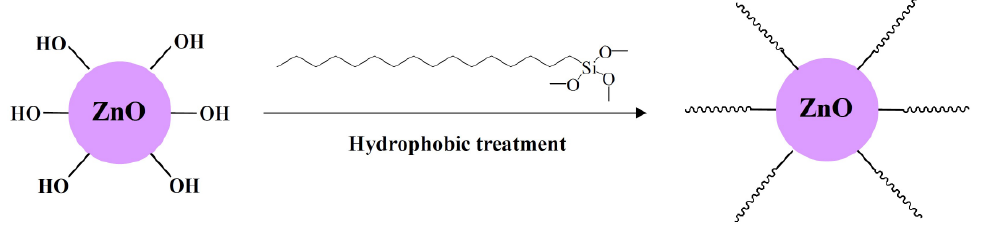
Figure 2. Surface modification mechanism of ZnO.